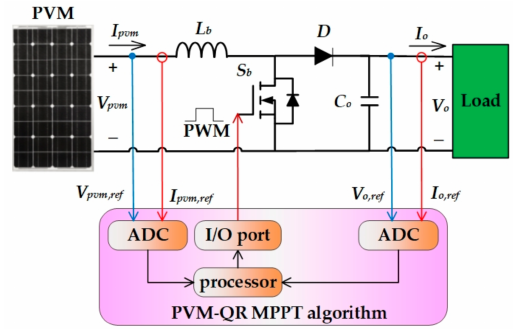
Figure 7. PVM connected to the power converter combined with the proposed PVM-QR MPPT controller schematic